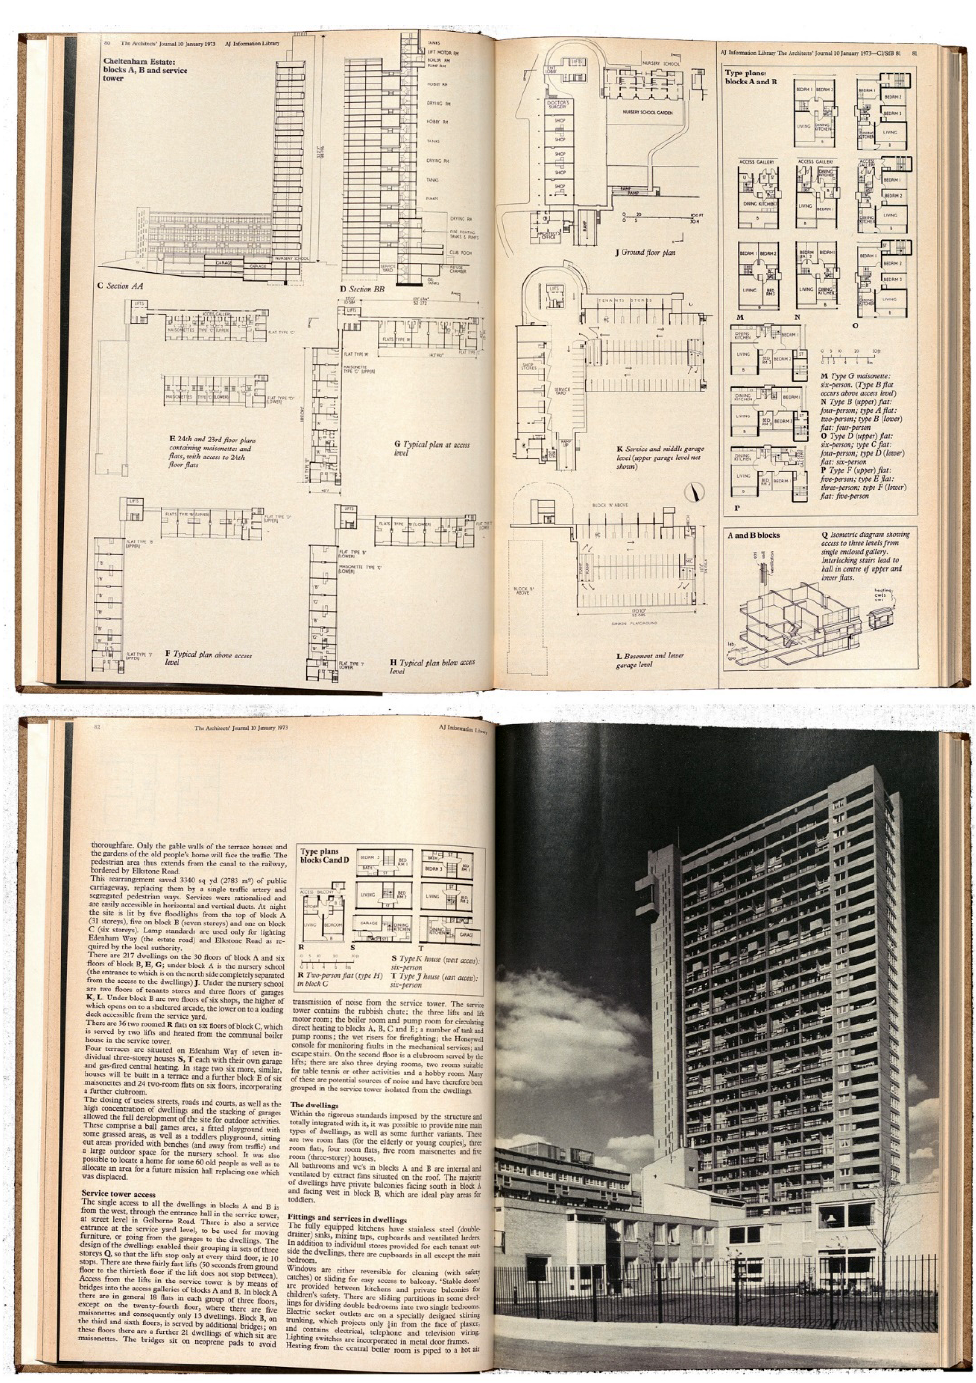
Figure 11. Richardson M. (1973). Cheltenham Estate housing, Architects’ Journal , 157